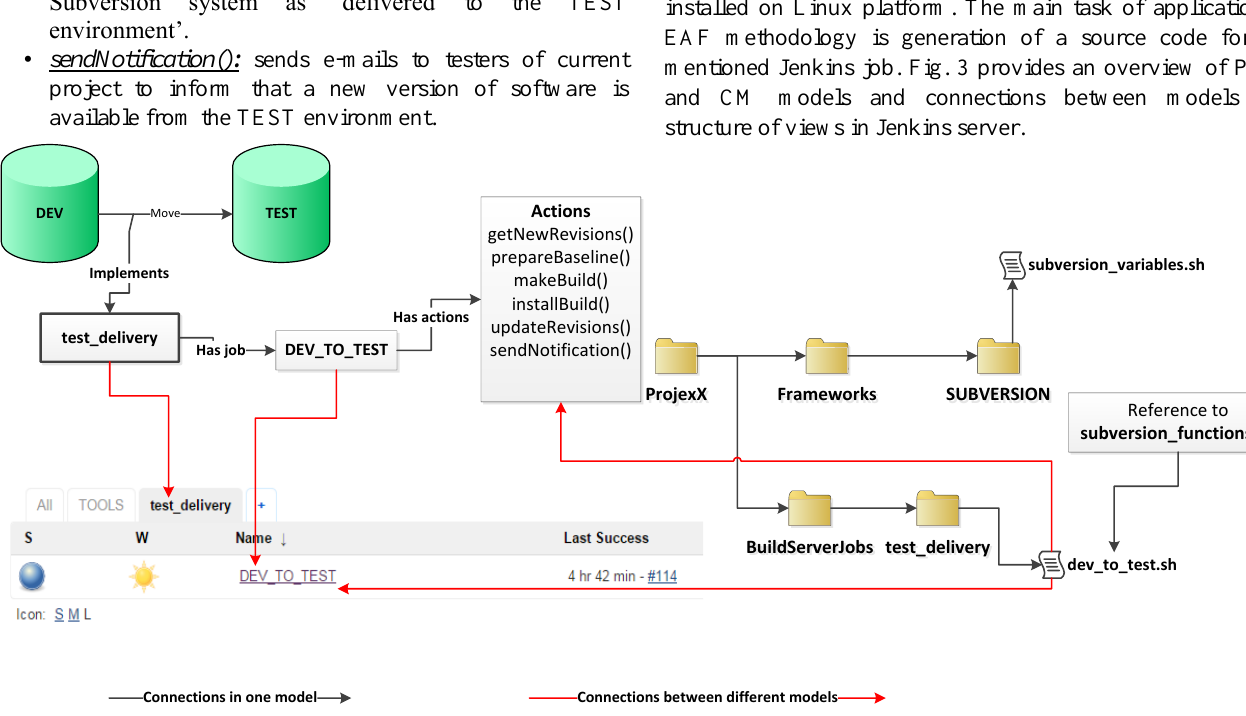
Fig. 3. Implementation of software configuration management by the EAF.